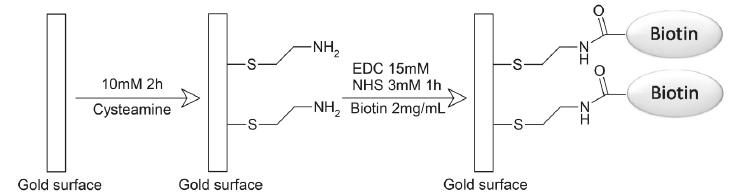
Figure 3: SPR sensor modification